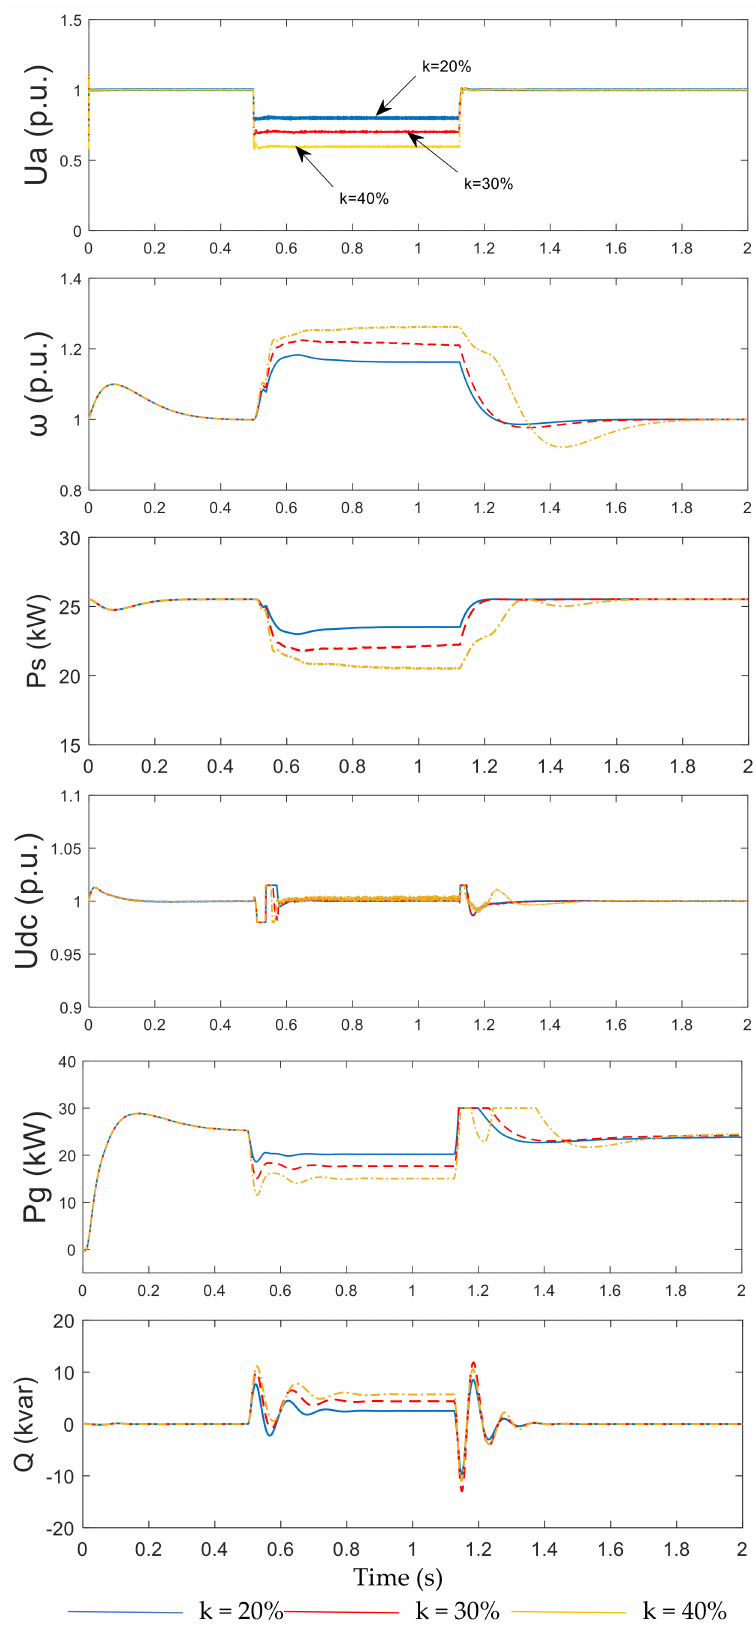
Figure 11. The simulation results of the rotor overspeed control